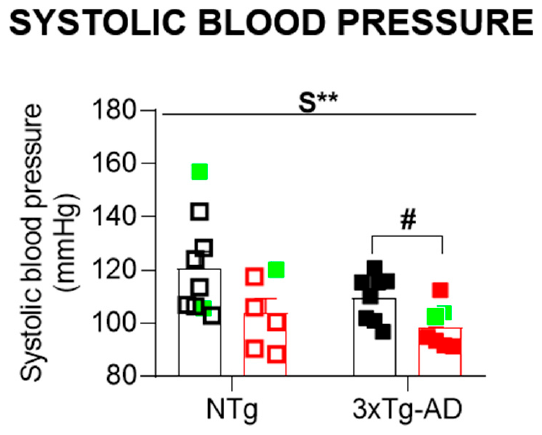
Figure 4. Systolic blood pressure. Results are the mean ± SEM. Bars illustrate the genotype groups, as indicated in the abscissae. Symbols are used to illustrate individual values of males (black, left panel) and females (red, right panel). In green: the no-survivors. Genotype (G) and sex (S) effects and GxS interaction were analyzed by 2 × 2 factorial ANOVA analysis, ** p < 0.01 (above line). Student t -test comparisons: ** p < 0.01, vs. the corresponding NTg group; # p < 0.05 vs. the corresponding male group.